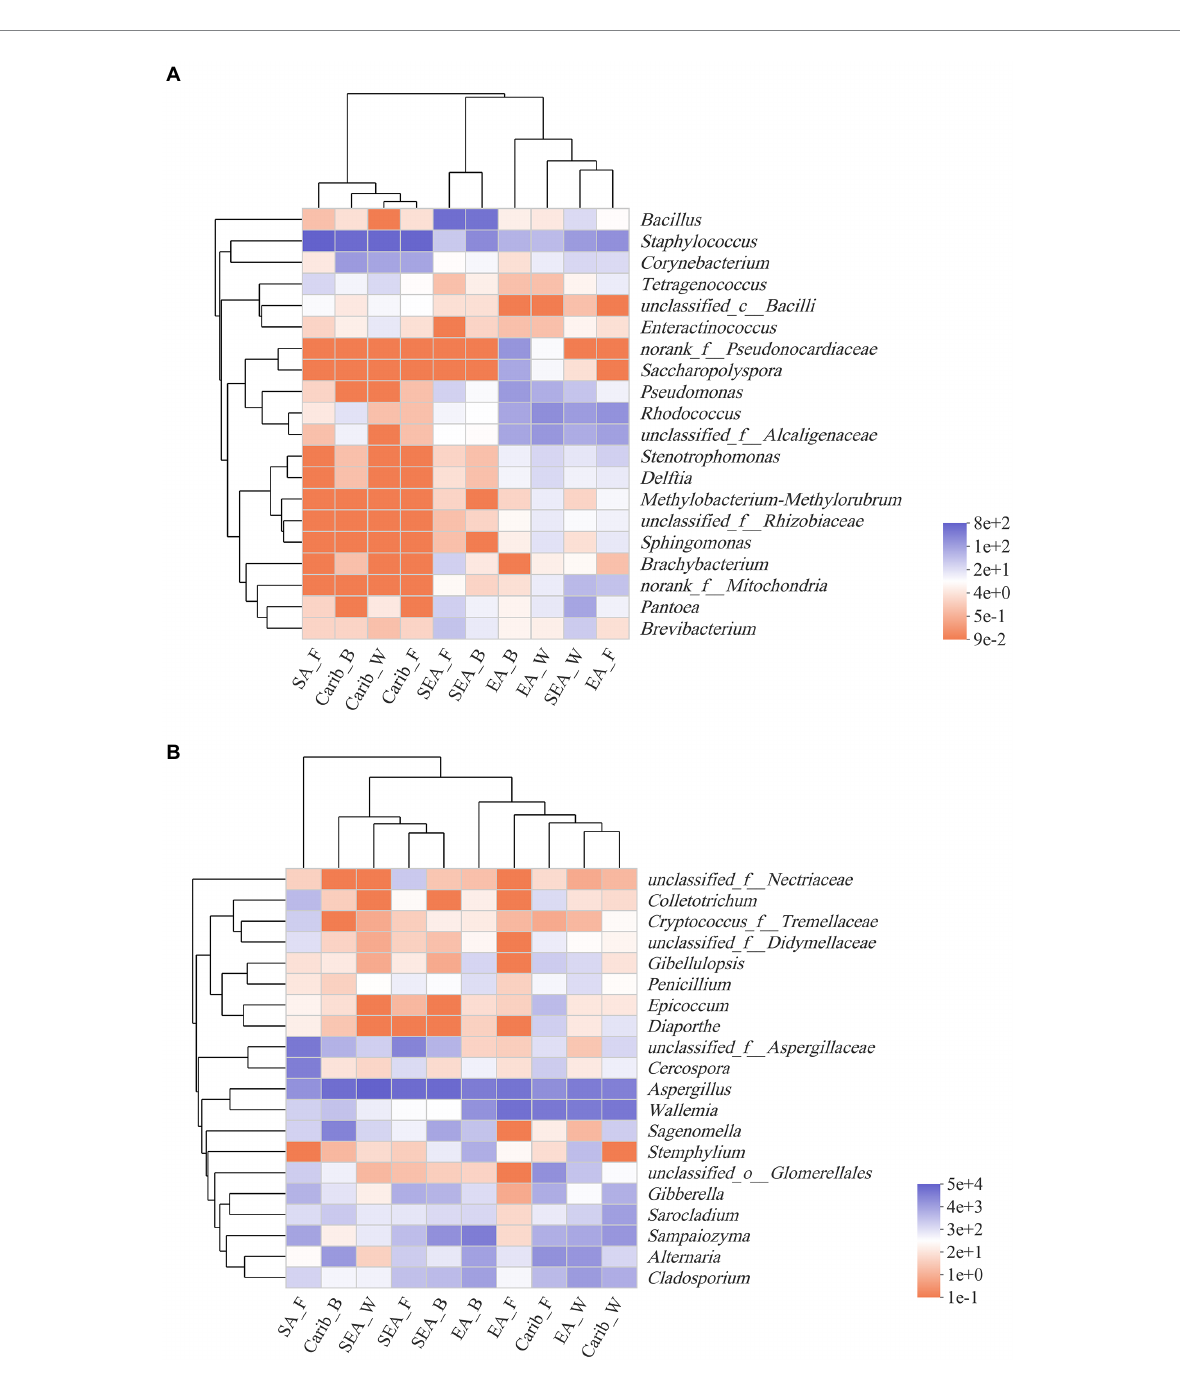
FIGURE 5 Heatmap of bacterial (A) and fungal (B) community at genus level based on cluster